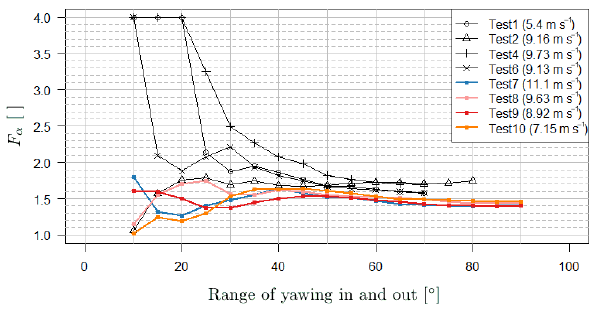
Figure 6. Sensitivity of the F α to the yawing span. Bold coloured lines are tests performed for the exact same rotor position. For test 2 the wind turbine was yawed by ± 60 ◦ , but an initial offset of the tur- bine with respect to the wind direction and a wind direction change during the test determined measurements up to 80 ◦ . The values in the legend show the mean wind speed during the test.